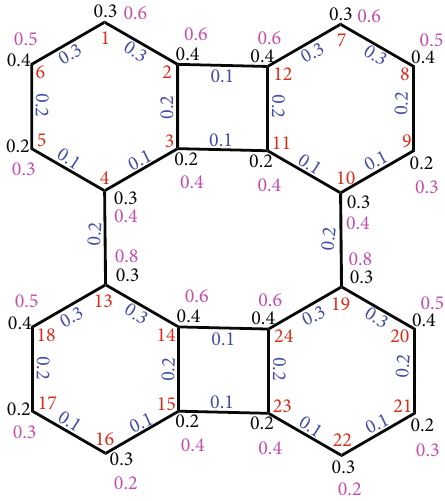
Figure 3: (2, 2) unit of fuzzy graph of phenylene.